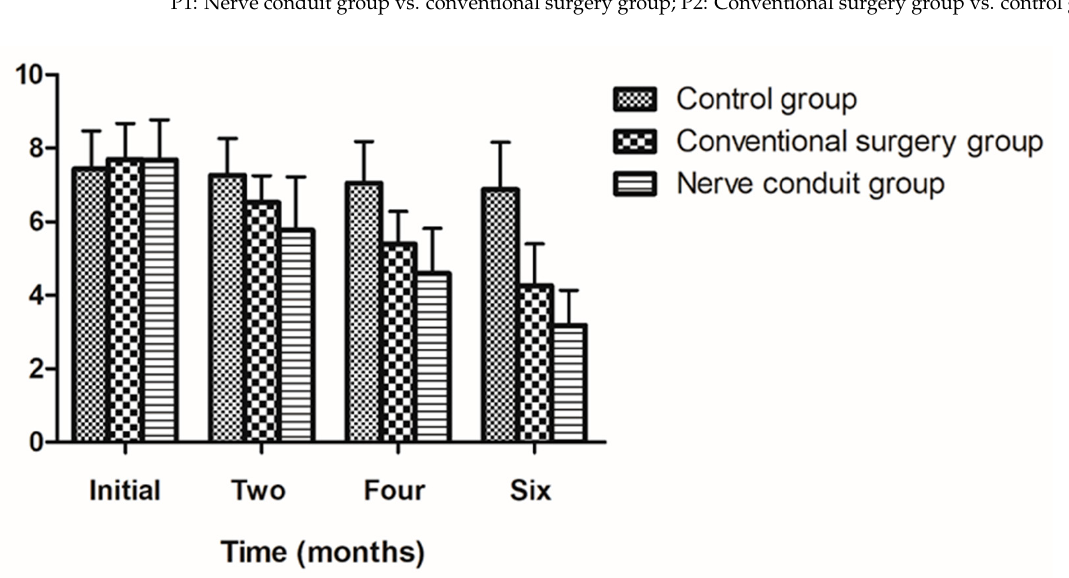
Table 3. Pre- and post-operative TCSS scores in di ff erent groups.